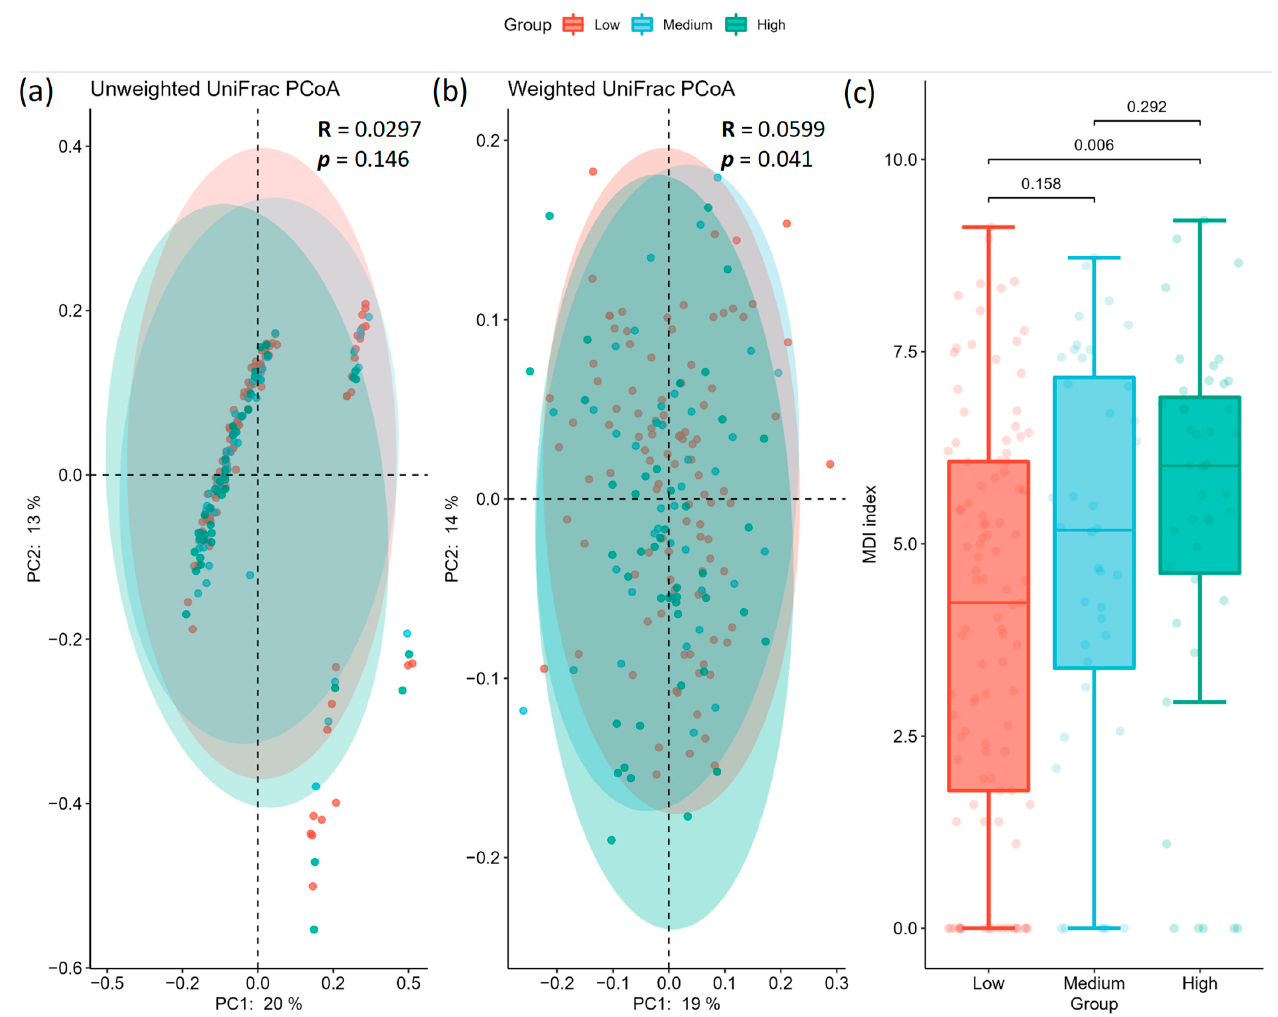
Figure 2. Comparisons of the microbiota β -diversity and MDI index. PCoA representation using ( a ) unweighted and ( b ) weighted normalized UniFrac distance matrix, while each dot represents one sample. ( c ) MDI index comparison where p values for pairwise comparisons are shown on each pair of brackets.